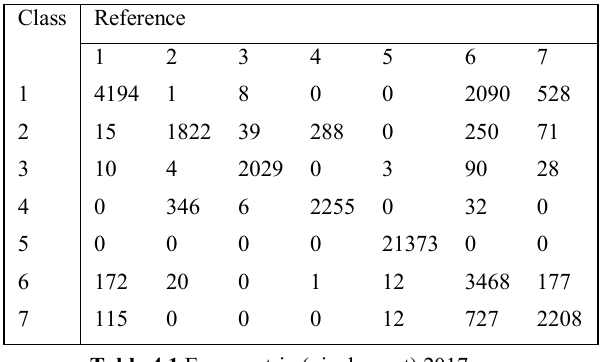
Table 4.1 Error matrix (pixel count) 2017 year